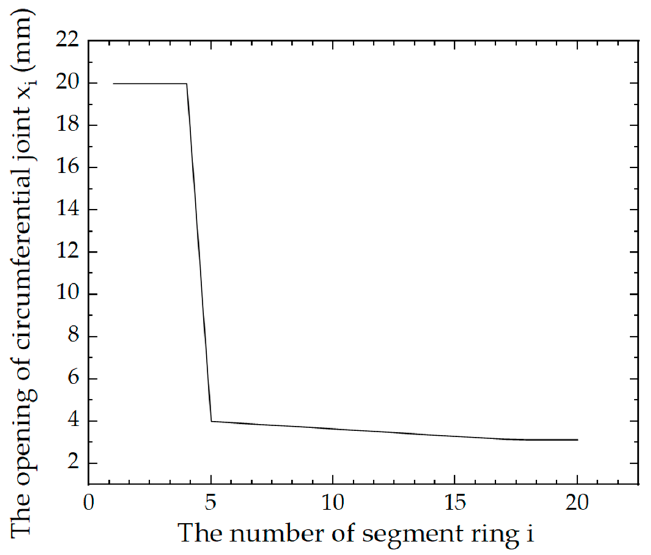
Figure 10. The relationship curve of the opening of circumferential joints after thrust unloading.